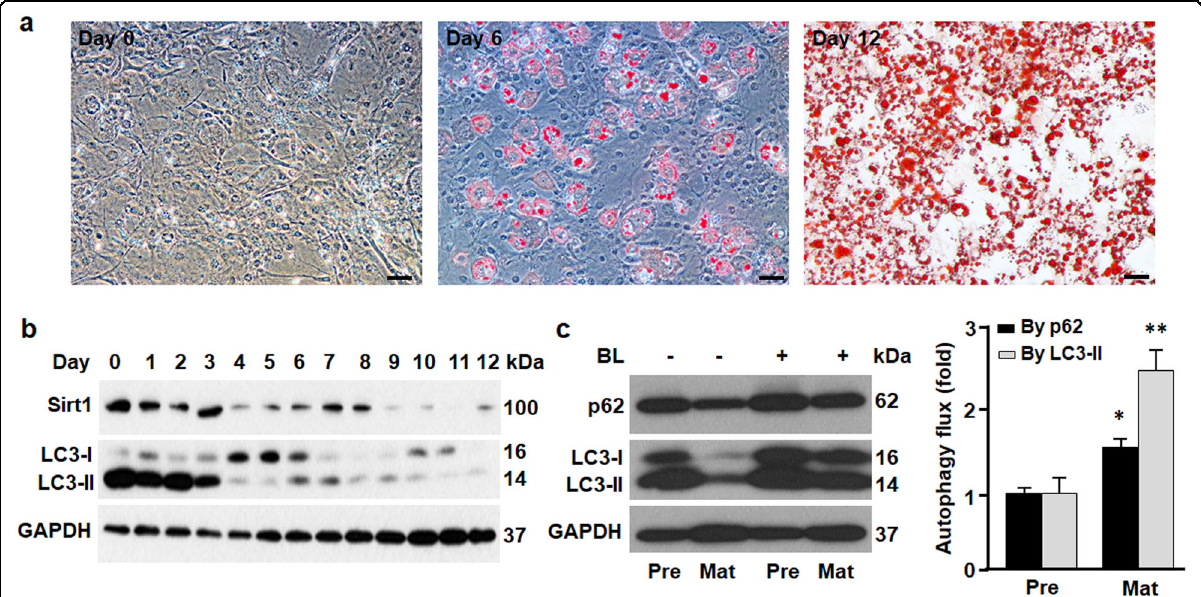
Fig. 1 Adipogenesis was associated with downregulation of Sirt1 and activation of autophagy. a Oil red O staining of 3T3L1 cells during differentiation, showing the data of day 0 (preadipocyte), day 6 (differentiating adipocyte), and day 12 (differentiated or mature adipocyte). Scale bar, 50 µm. b Western blotting analysis of Sirt1 and LC3 proteins during 3T3L1 cell differentiation. GAPDH was probed as a loading control. c Autophagy fl ux was determined by contrasting the rates of removing the substrates LC3-II and p62 by autophagy in the absence and presence of autophagy inhibitors BL (ba fi lomycin A1 at 0.1 μ M and leupeptin at 10 μ g/ml). Pre, preadipocyte; Mat, mature adipocyte. * p < 0.05; ** p < 0.01. n =